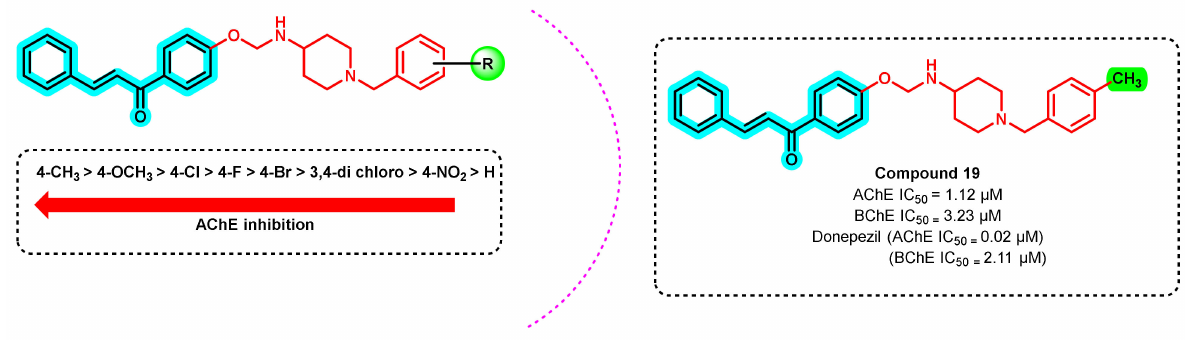
Figure 20. Chalcone benzyl piperidine